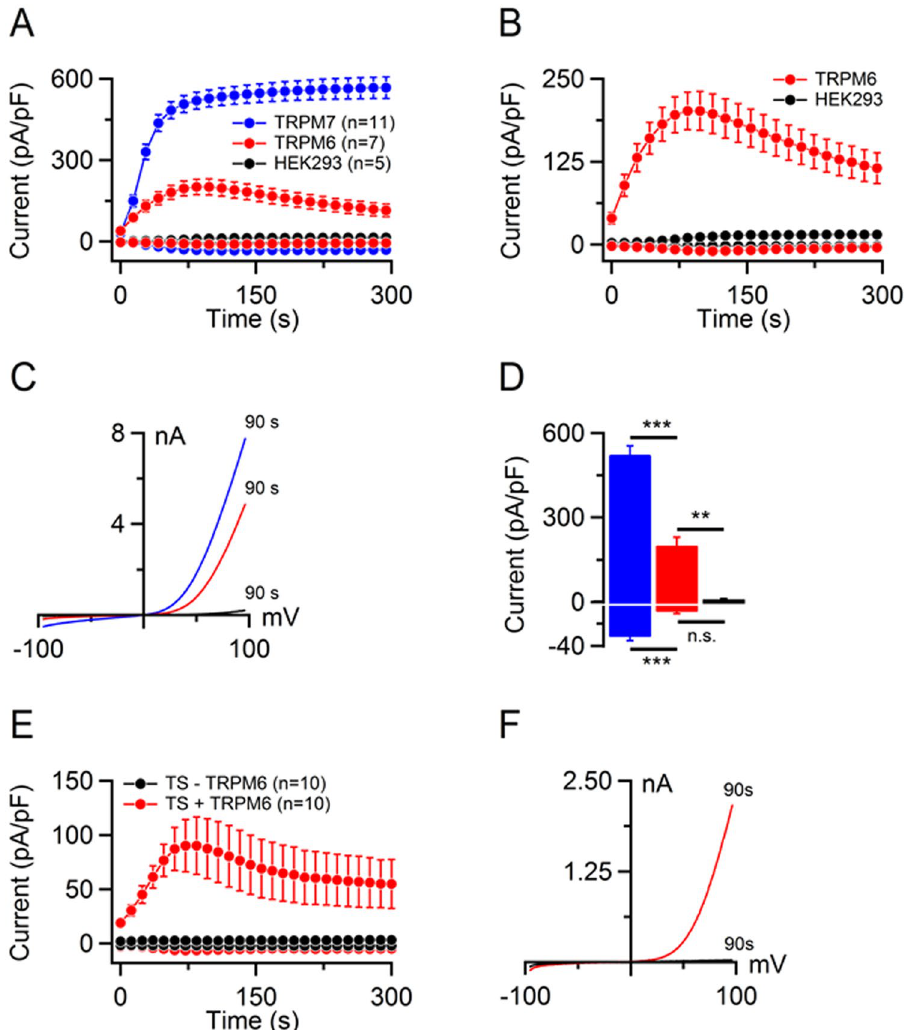
Figure 2. Assessment of mTRPM6 and mTRPM7 currents in HEK 293 and TS cells. ( A ) Whole-cell currents measured in mTRPM6 (red), mTRPM7-transfected (blue) and untransfected (black) HEK 293 cells. Current amplitudes (mean ± SEM) were acquired at − 80 and + 80 mV and plotted over time. ( B ) Magnification of mTRPM6 and endogenous TRPM7 currents shown in (A). ( C ) Representative current-voltage (I-V) relationships of currents (at 90 s) illustrated in (A). ( D ) Bar graphs of outward ( Upper panel) and inward ( Lower panel) currents (mean ± SEM) shown in (A) at 90 s. n, number of cells measured; n.s., not significant; ** P < 0.01; *** P < 0.001 (ANOVA). ( E , F ) Functional expression of mTRPM6 in trophoblast stem (TS) cells. Trpm7 -gene deficient TS cells were electroporated with mTRPM6 cDNA and examined as described in ( A ). ( E ) Whole-cell currents (mean ± SEM) measured in mTRPM6-transfected (red) and untransfected (black) TS cells. ( F ) I-V relationships of the currents (at 90 s) shown in ( E ). n, number of cells